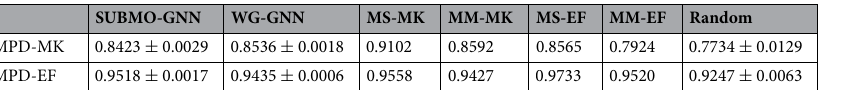
Table 2. MPD values with MACCS keys and ECFP. For SubMo-GNN, WG-GNN, and Random, means and standard deviations over five trials are